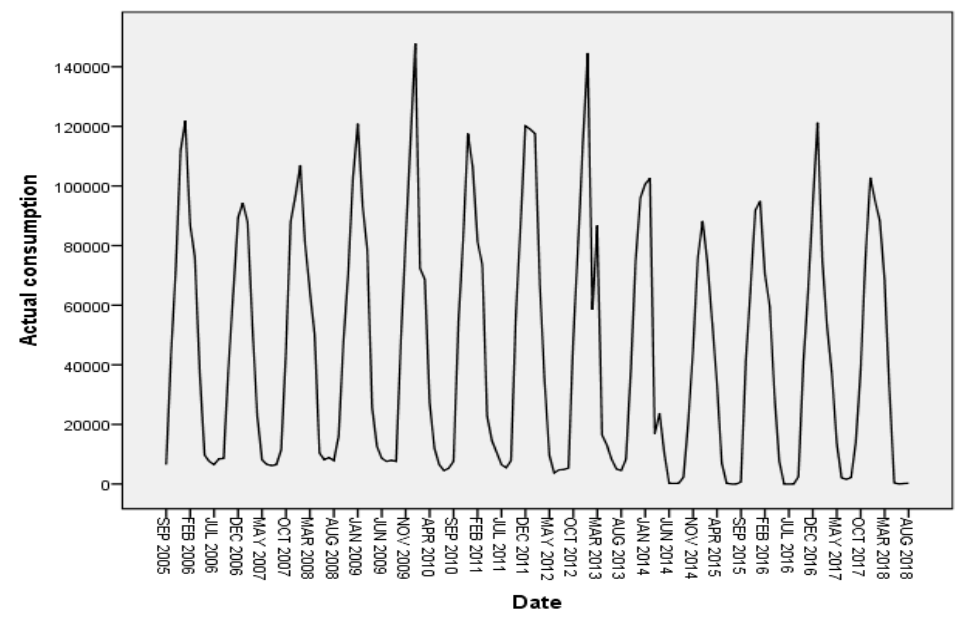
Figure 1. Time series of actual consumption for Best Practice 1 (BP1).